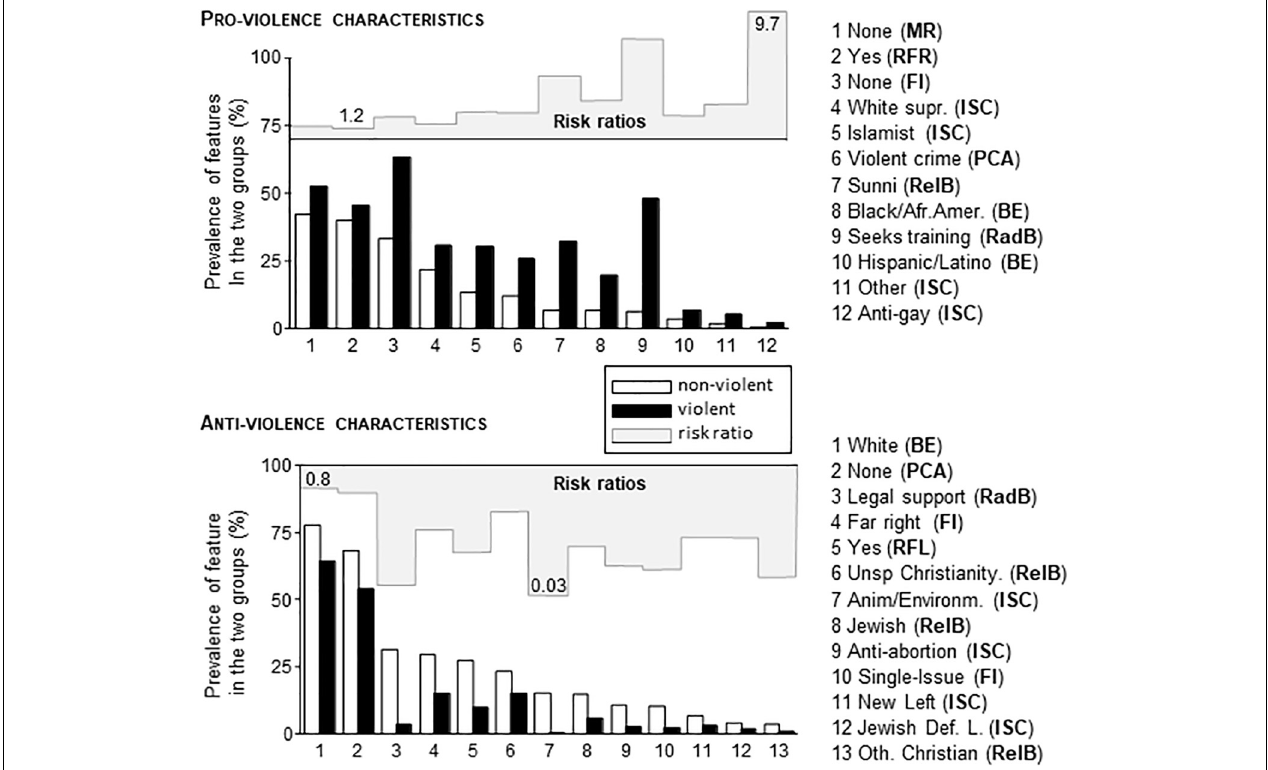
FIGURE 2 | The share of various characteristics in non-violent and violent individuals of the PIRUS database. Characteristics were selected based on Multiple Regression analysis. The violent and non-violent groups were different in all cases after Bonferroni adjustment for repeated comparisons ( p < 0.05 at least). Characteristic names (as shown in the database) were followed by the abbreviation of the variable where the characteristic belonged. BE, Broad ethnicity; FI, Family Ideology; ISC, Ideological Sub-Category; MR, Media Radicalization; PCA, Previous Criminal Activity; RadB, Radical Behaviors; RFL, Radicalization Far Left; RFR, Radicalization Far Right; RelB, Religious Background. Risk ratios were also shown as graphs on a scale of 1–10 (pro-violence characteristics) and 0–1 (anti-violence characteristics). The smallest and largest risk ratios were numerically shown as reference values.